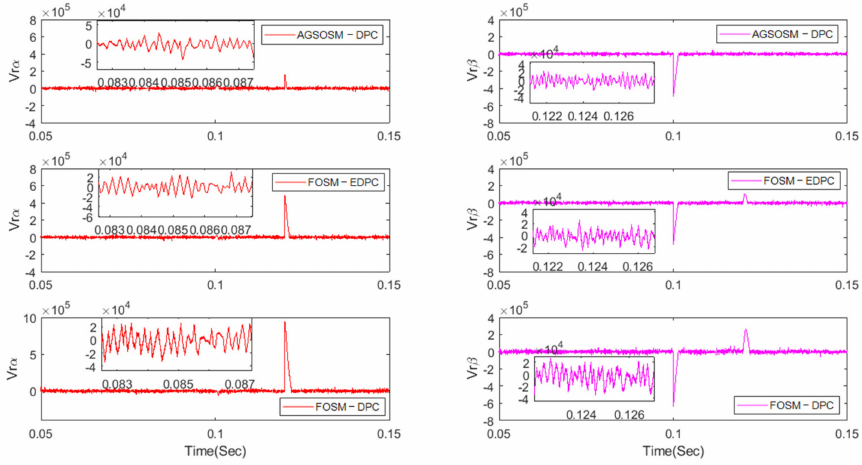
Figure 6. Control voltage under two phase stationary frame under balanced grid